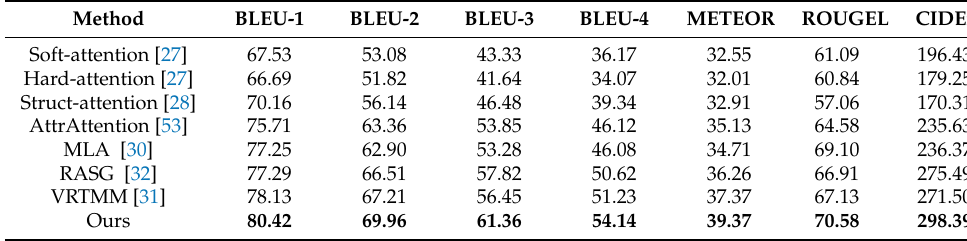
Table 3. Comparison scores (%) on RSICD data